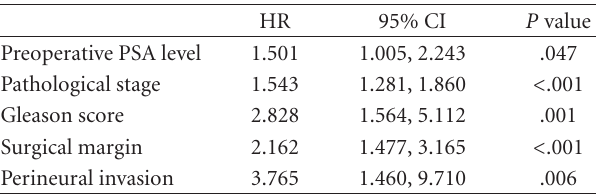
Table 4: Multivariate Cox proportional hazard model for predic- tion of PSA